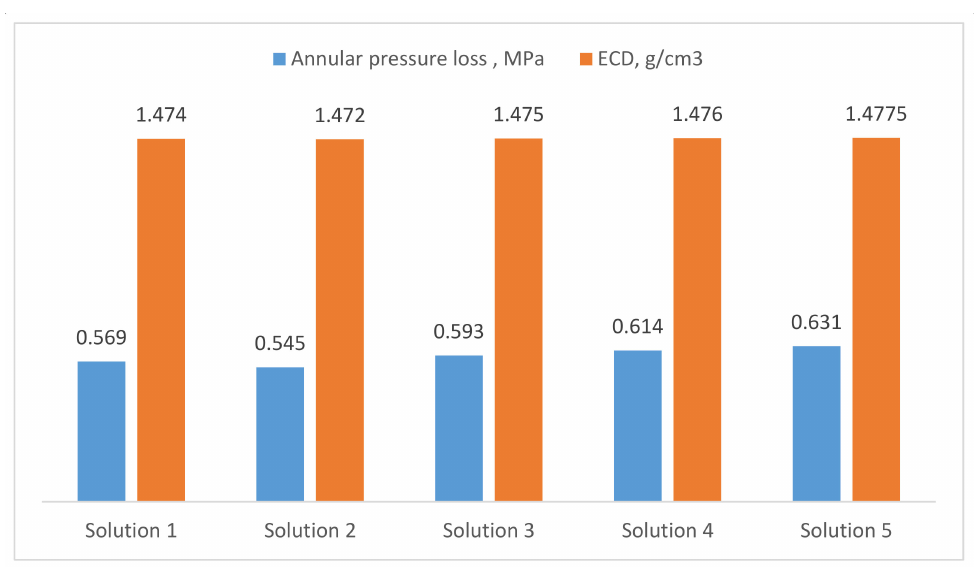
Figure 3. Calculation of pressure loss in the annulus and